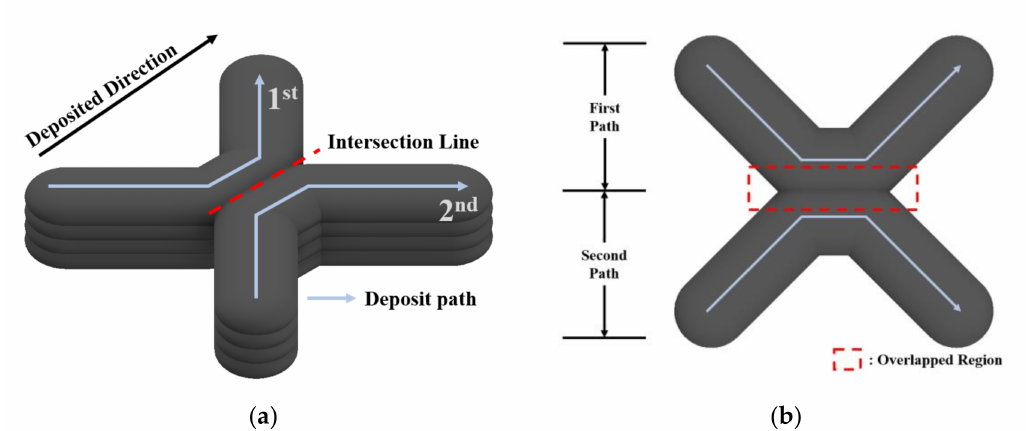
Figure 4. Suggested path planning in this paper. ( a ) a schematic diagram, ( b ) top view.